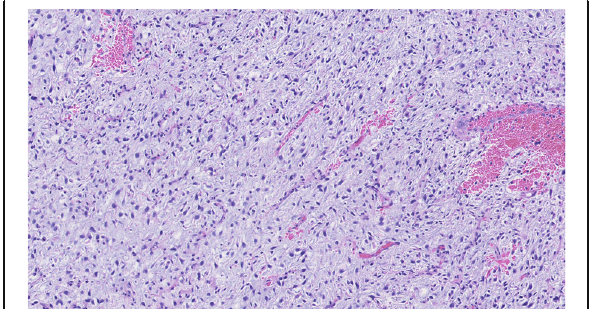
Fig. 2 Intermediate power magnification of × 150 reveals spindle cells in a rich myxoid stroma (HE